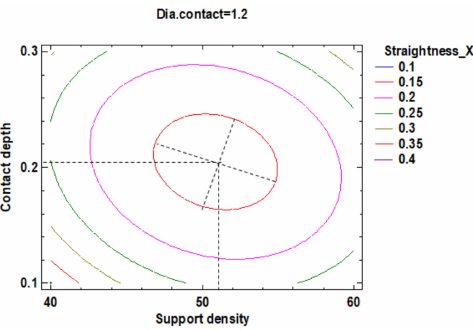
Figure 18. Contours of Estimated Response Surface for Straightness_X2 and centre diameter contact.